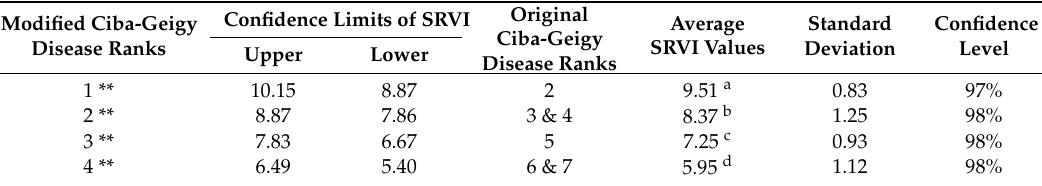
Table 5. Confidence limits for porosity values with modified Ciba-Geigy disease ranks. Modified Ciba-Geigy Disease